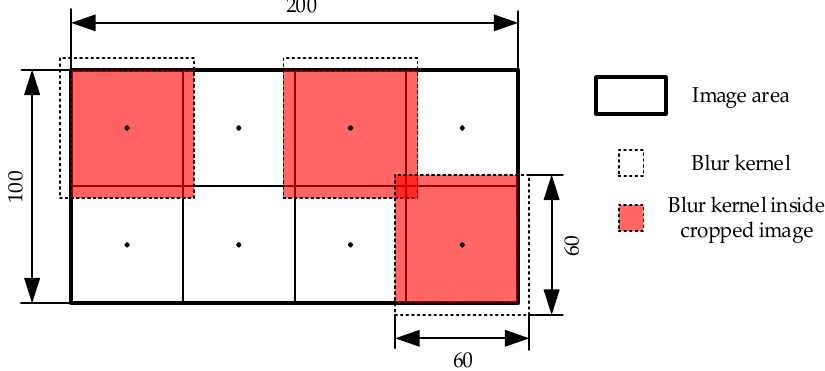
Figure 10. The calculation of the ratio of the blur kernel area in the image with kernel size = 40 × 40.